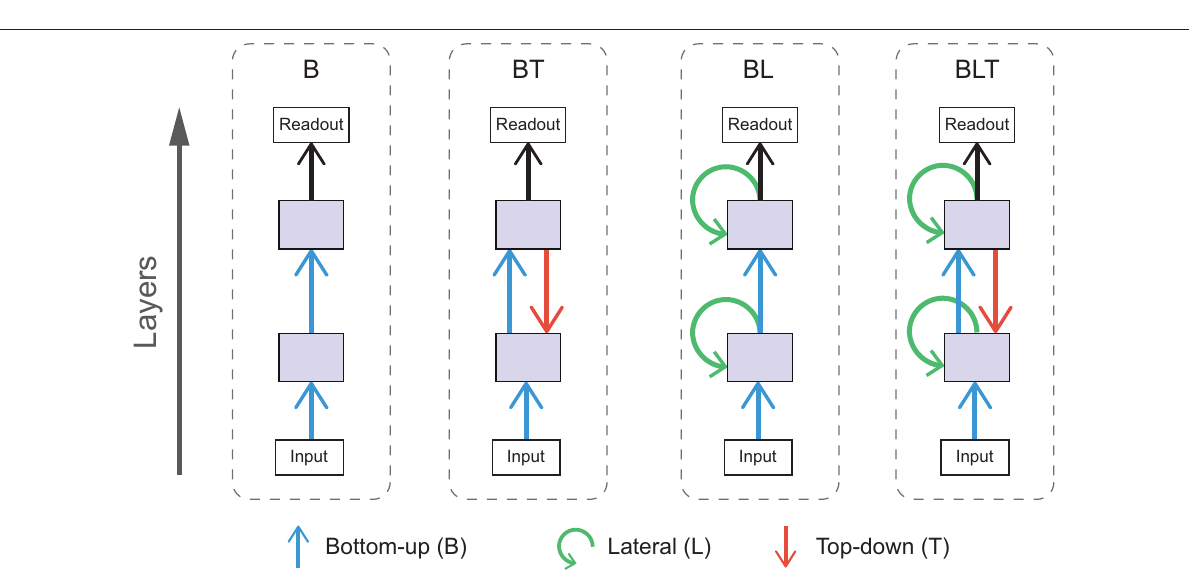
FIGURE 3 | Schematic diagrams for each of the architectures used. Arrows indicate bottom-up (blue), lateral (green), and top-down (red)